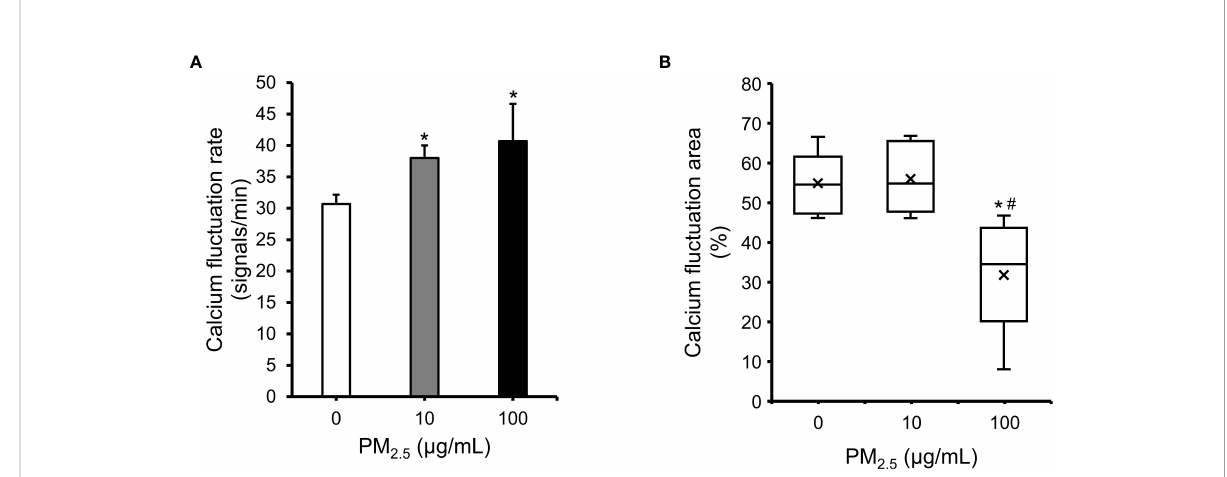
FIGURE 6 Impairment in cardiac calcium fl uctuation in PM 2.5 -treated HL-1 cells. (A) Calcium fl uctuation rates of 0, 10, and 100 m g/mL PM 2.5 -treated cells. The graph indicates the number of calcium fl uctuation signals per min. (B) Calcium fl uctuation area of PM 2.5 -treated cells. The box plot shows the cell area with calcium fl uctuation signals from randomly selected microscope fi elds. Calcium fl uctuation videos were acquired in six fi elds per condition. × indicates average. The internal horizontal line indicates the median value. * p -value < 0.05 vs. control; # p -value < 0.05 vs. 10 m g/mL PM 2.5 -treated